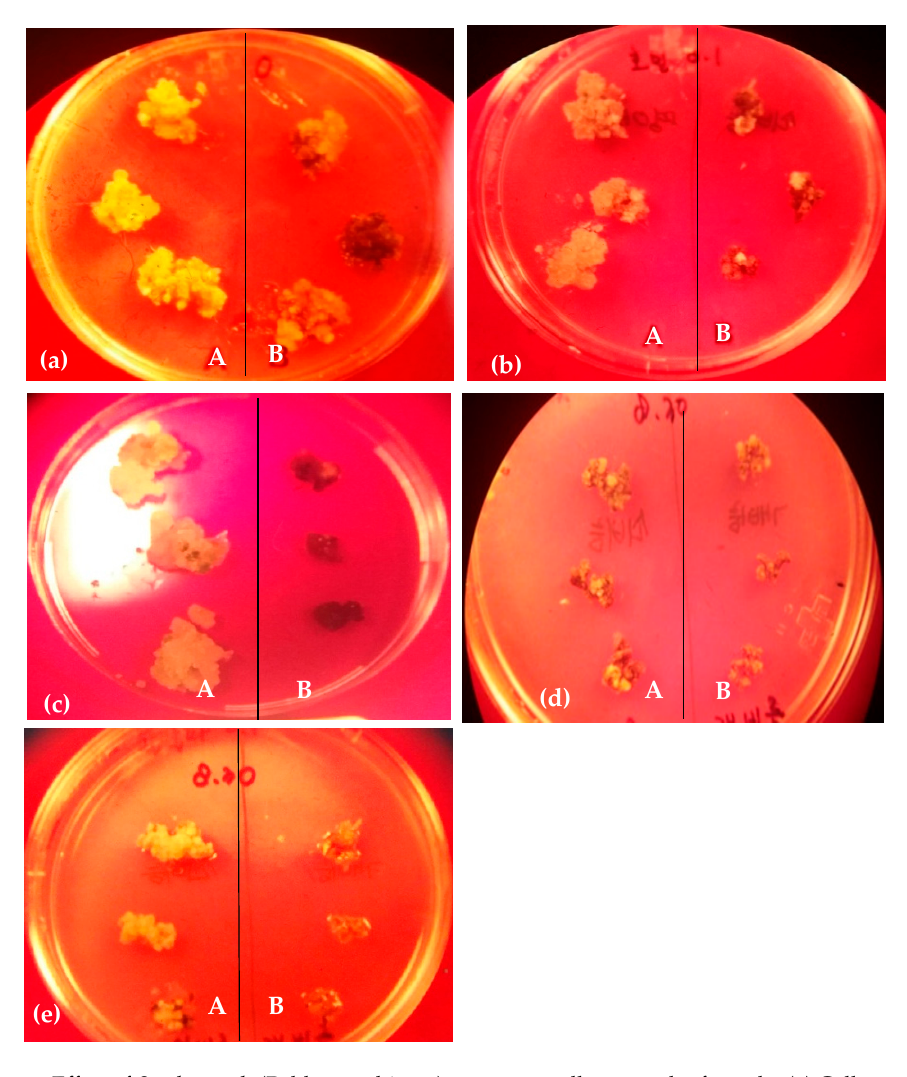
Figure 1. E ff ect of Secale cereale (Paldong cultivars) extract on callus growth of weeds. ( a ) Callus growth in the absence of S. cereale extract: (A) Callus of Chenopodium Album , (B) callus of Portulaca oleracea . ( b ) Callus growth in the Murashige and Skoog (MS) medium supplemented with 0.1% S. cereale extract: (A) callus of C. album , (B) callus of P. oleracea. ( c ) Callus growth of C. communis (A) in the absence of S. cereale extract and (B) in 5% S. cereale extract. ( d ) Callus growth of Digitaria ciliaris (A) in the absence of S. cereale extract and (B) in 0.1% S. cereale extract. ( e ) Callus growth of Pinellia ternata (A) in the absence of S. cereale extract and (B) 0.1% S. cereale extract.